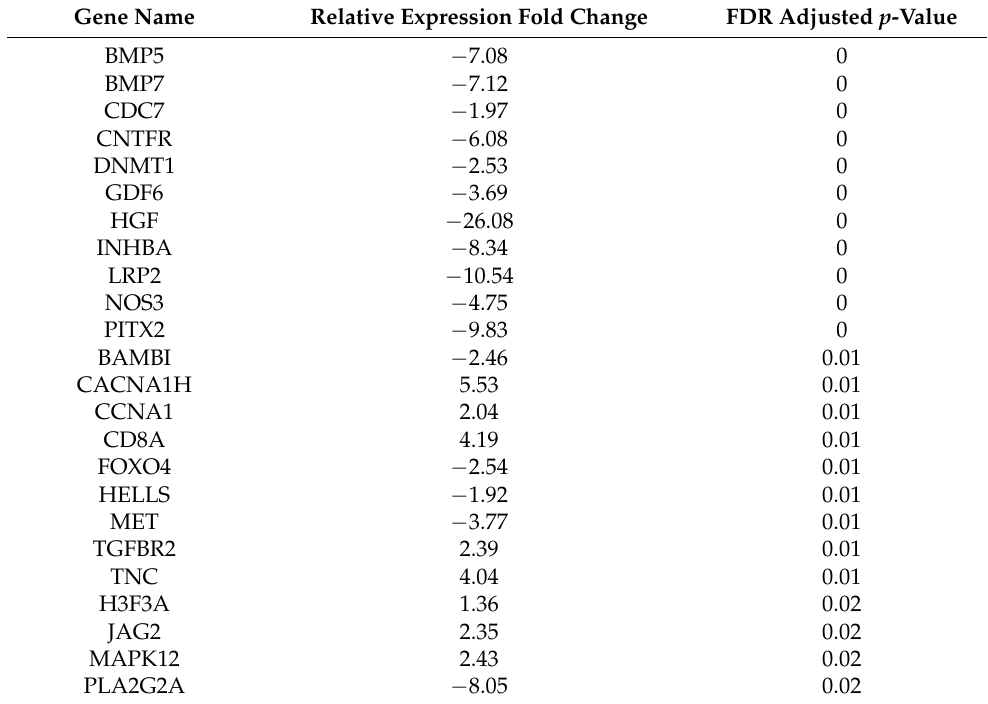
Table 2. Differentially expressed genes between complete hydatidiform mole and postmolar chorio- carcinoma samples (FDR <